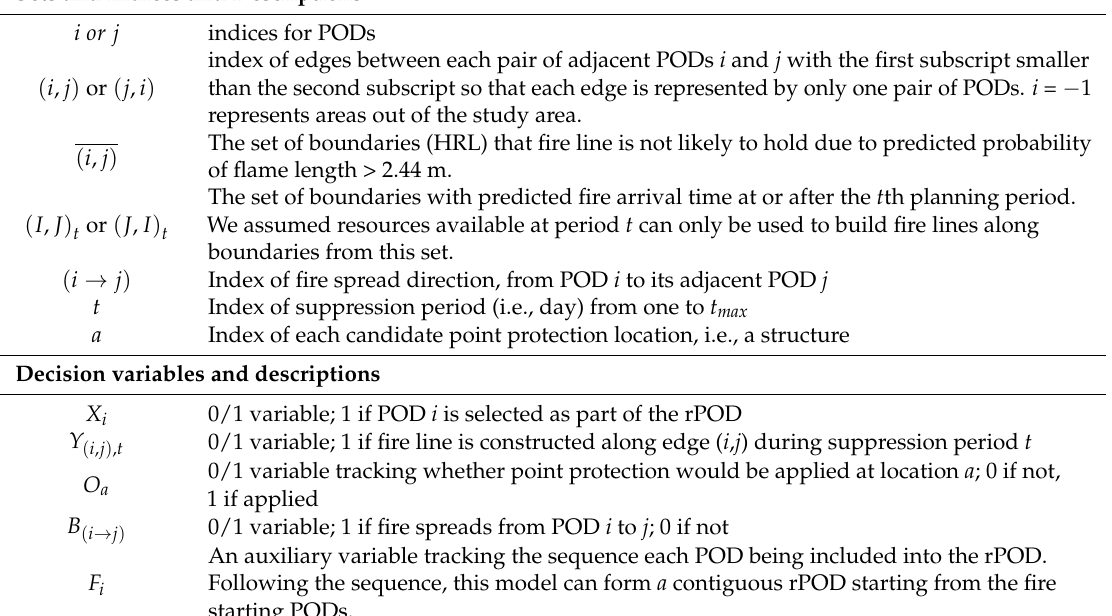
Table 1. Denotations used in the first step optimization